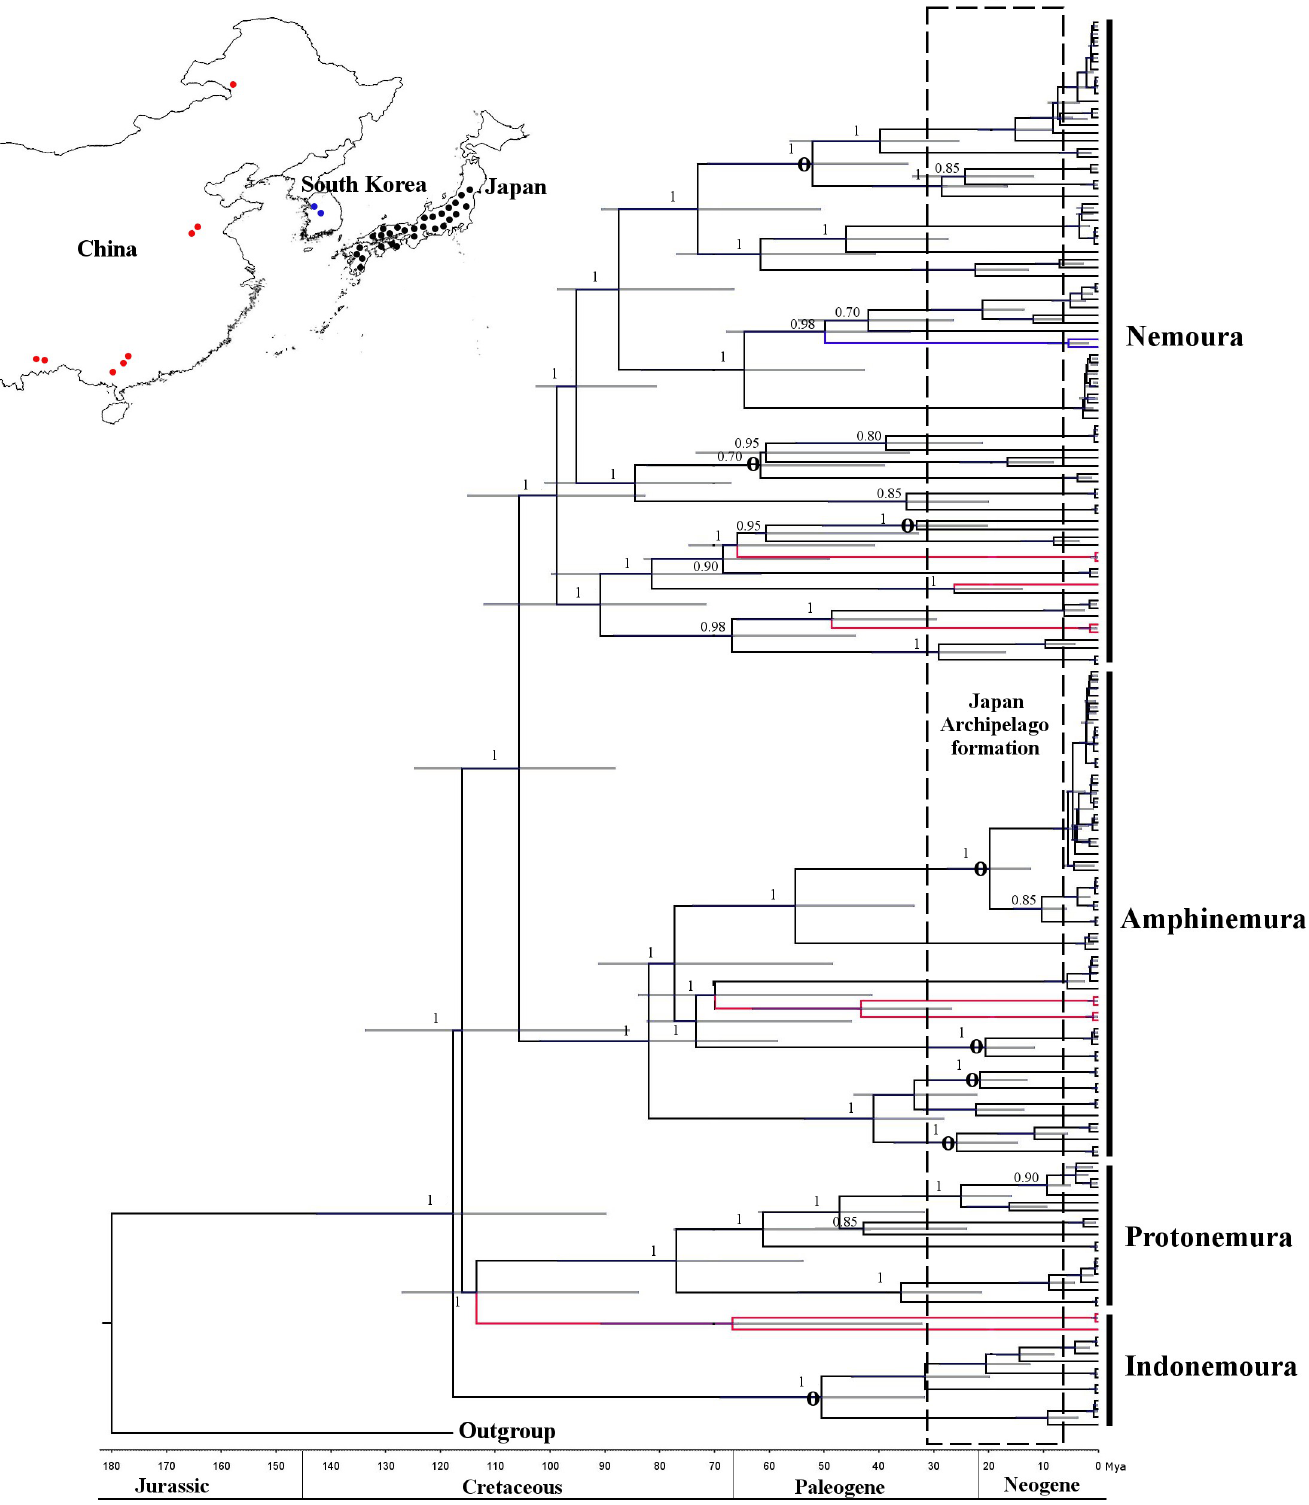
Fig 2. Concatenated Bayesian phylogeny ( cox1 + H3 ) of the East Asian Nemouridae family. The phylogenetic tree nodes were calibrated using 180 Ma based on fossil records + 15 to 30 Ma based on the Japanese Archipelago formation. Calibration and geological time are shown at the bottom of the tree. A 95% HPD is indicated as a horizontal grey bar and posterior probabilities are shown for each node. Circle symbol ( O ) in the nodes indicates intra-species diversification based on